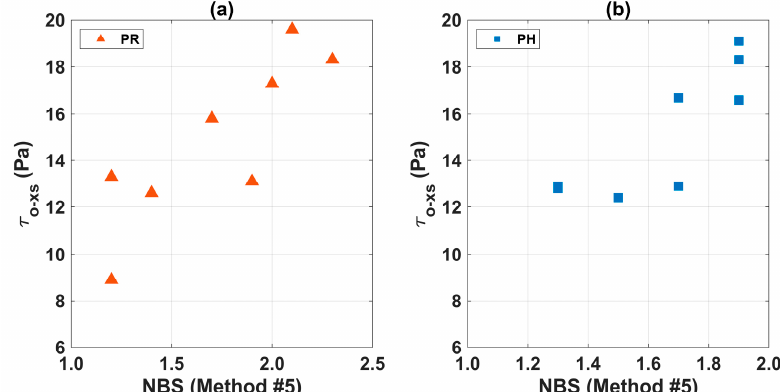
Figure 6. Correlation between BSTEM process-based predictions of τ o at each cross-section ( τ o-xs ) and NBS (Method #5) form-based parameterizations of τ o for the ( a ) Post-Restoration (PR) and ( b ) Post-Hurricane (PH) geometries. Ratings for NBS (Method #5) are: Very Low (<1.0); Low (1.0–1.5); Moderate (1.5–1.8); High (1.8–2.5); Very High (2.5–3.0); and Extreme (<3.0) [14].